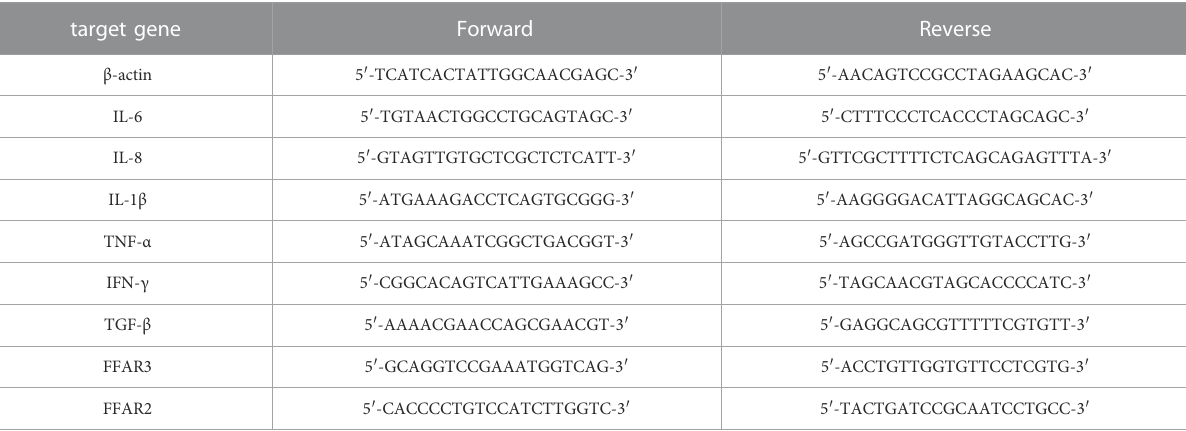
TABLE 1 Primer sequences of the target